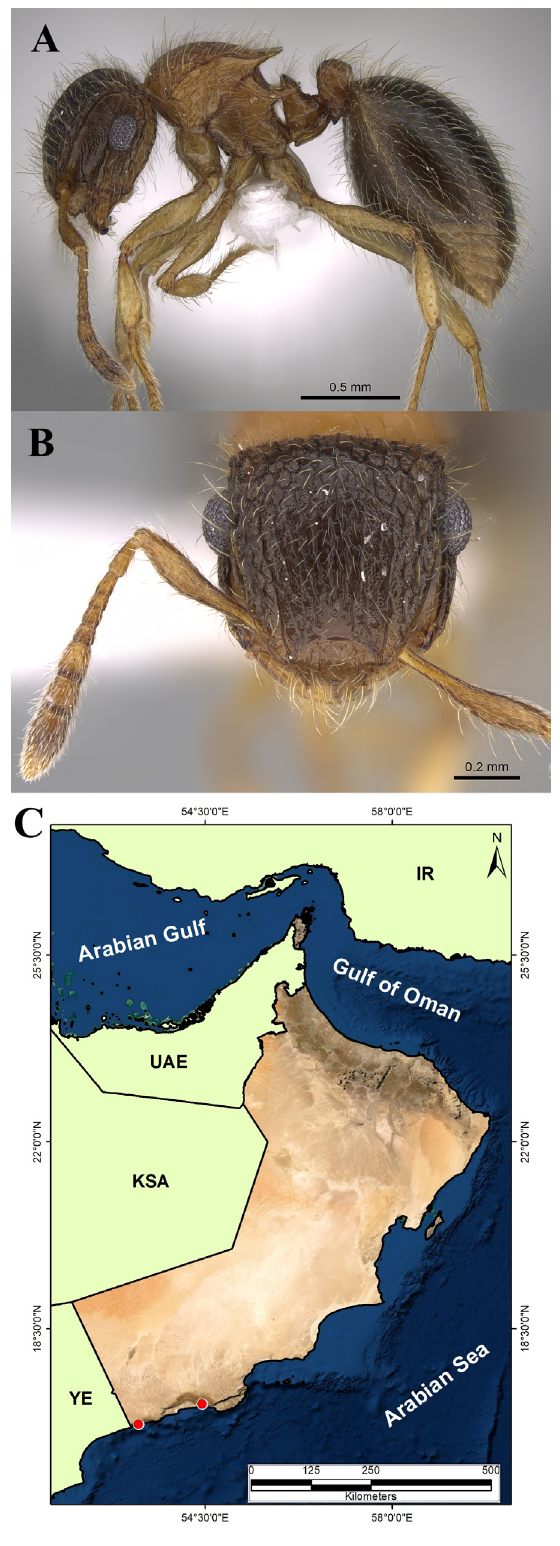
Fig. 33. Meranoplus mosalahi Sharaf, 2019, paratype, worker (CASENT0922861, AntWeb.org (Michele Esposito)). A . Body in profile. B . Head in full-face view. C . Distribution